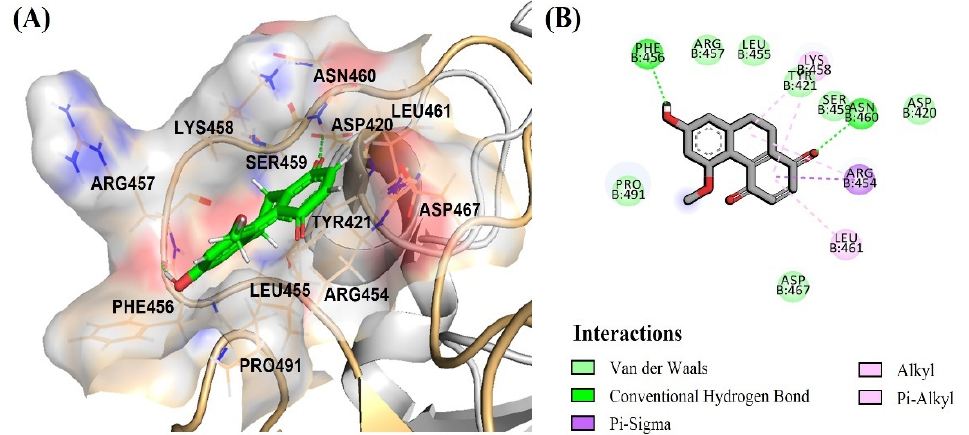
Figure 8. Binding mode of DB36 (green color) located in the binding motif (RBM) region: ( A ) surface view of DB36 binding mode; ( B ) amino acid interactions of DB36.